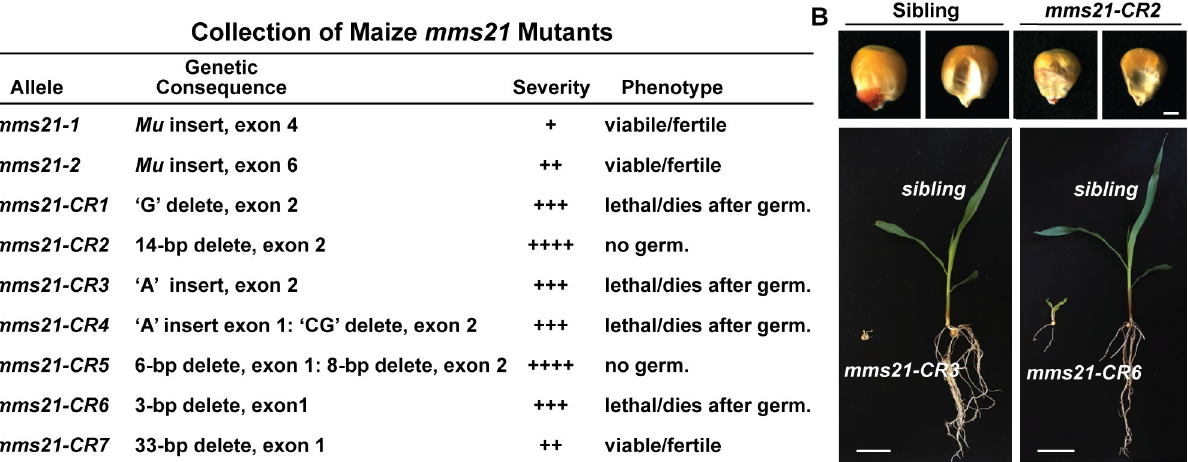
Fig 2. Maize mms21 Mutants Display Defects in Vegetative Growth and Reproduction. (A) W22 and homozygous mms21 plants imaged 14 DAS. The UniformMu mms21-1 and mms21-2 alleles are described in Fig 1. (B) W22 and homozygous mms21 plants imaged at maturity (70 DAS). (C) Chronological display of the leaves, tassels, and ears from individual W22, mms21-1 , and mm21-2 plants at maturity. (D) Quantification of plant height and ligule number over time as measures of developmental progression. Each bar represents measurements of 4 plants ( ± SD). (E) Allelism test showing that transheterozygous progeny, generated by crossing the two mutant alleles, are phenotypically similar to plants homozygous for mms21-1 or mms21-2 . (F) Flowering is impaired in homozygous mms21-1 and mms21-2 plants. Shown are tassels and cobs at maturity. mms21 mutants have reduced silking and closeup of anthers show limited anthesis from tassels. (G) Layout of representative anthers obtained from W22 and mutant tassels. mms21-2 anthers are mostly aborted. Scale bar = 8 mm. (H) mms21 pollen germinates poorly. Shown are pollen from W22, mms21-1 , and mm21-2 anthers incubated on germination medium for 3 hr at 28˚C. Scale bar = 1 mm. (I) Quantification of pollen germination efficiency shown in (H). Each bar represents the average of three biological replicates ( ± SD), each measuring at least 100 pollen grains. (J) Mature ears from self-pollinated W22 and mms21 /+ heterozygous plants showing the appearance of defective seeds (arrowheads). (K) Abnormal morphology of mms21-1 and mms21-2 seeds as compared to their normal siblings. The abgerminal (top), germinal sides (middle), and the saggital sections (bottom) of a representative seed are shown. Scale bar = 2 mm. (L) mms21-2 seeds are smaller. Shown are whole seeds and a sagittal plane section showing variability in embryo size and possibly premature endosperm starch accumulation in seeds harvested from self-pollinated mms21-2/+ plants at 16 DAP. Scale bar = 3 mm. (M) mms21 seeds weigh less than their normal siblings. Each bar represents the weight of 50 seeds ( ± SE) from three biological replicates obtained from mms21-1 and mms21-2 and their heterozygous siblings collected at maturity. (N) Quantification of weight of seeds, endosperm, and embryos dissected from self-pollinated W22, mms21-1 , and mms21-2 cobs at 24 DAP. Each bar represents the average ( ± SD) of 50 seeds.